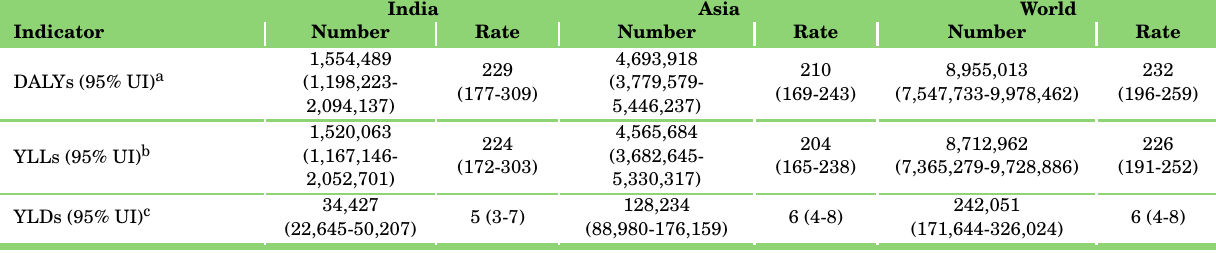
GBD2019DiseasesandInjuriesCollaborators. Globalburdenof369diseasesandinjuriesin204countriesandterritories,1990-2019: asystematicanalysisfortheGlobalBurdenofDisease Study 2019. Lancet. 2020 Oct